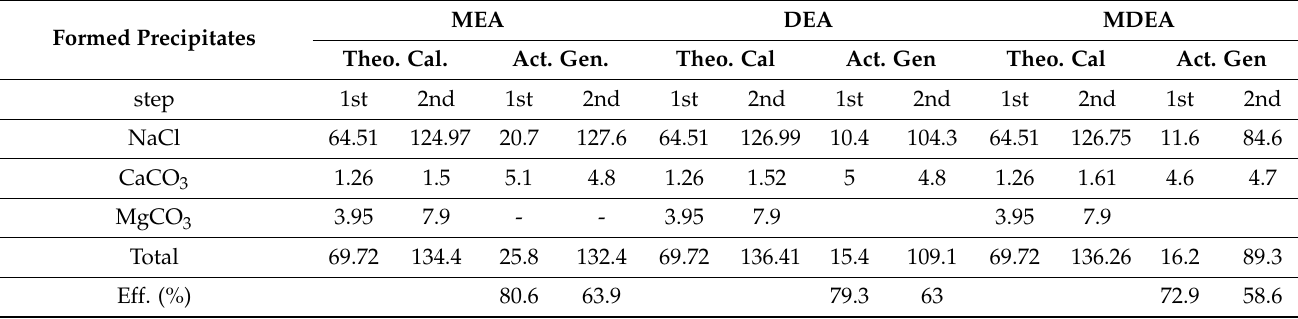
Table 3. Amount of precipitates formed in each step and for each solution. Formed Precipitates